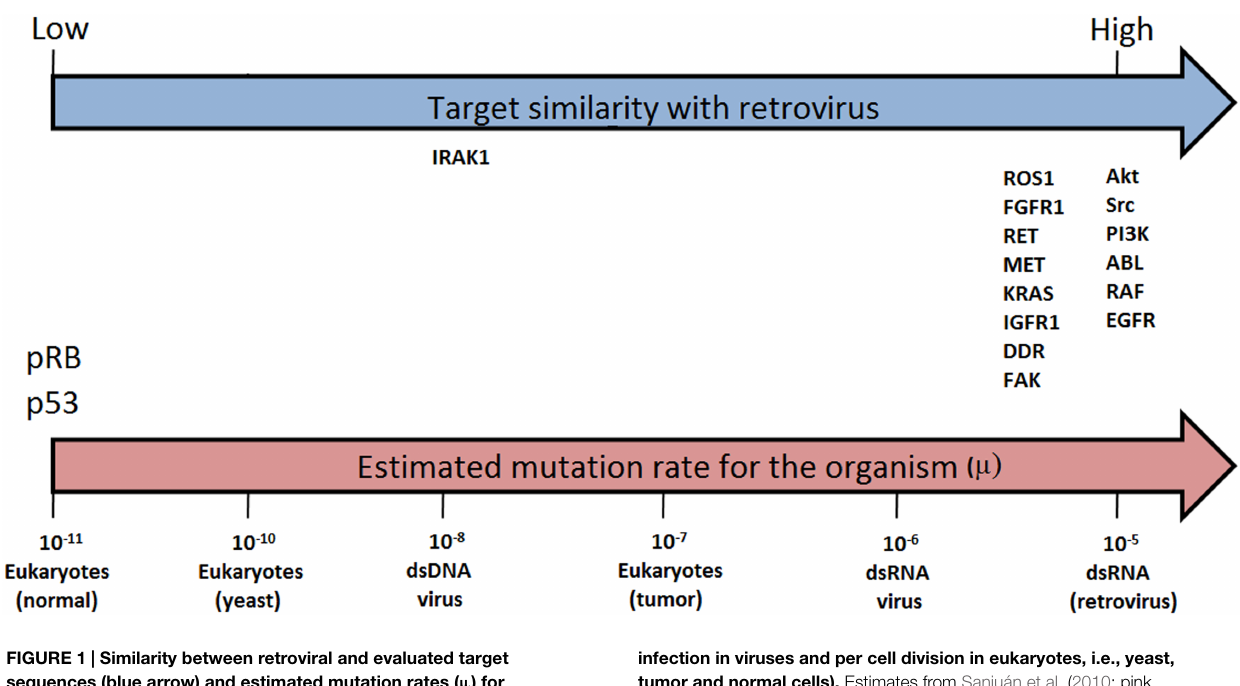
infection in viruses and per cell division in eukaryotes, i.e., yeast, tumor and normal cells). Estimates from Sanjuán et al. (2010; pink